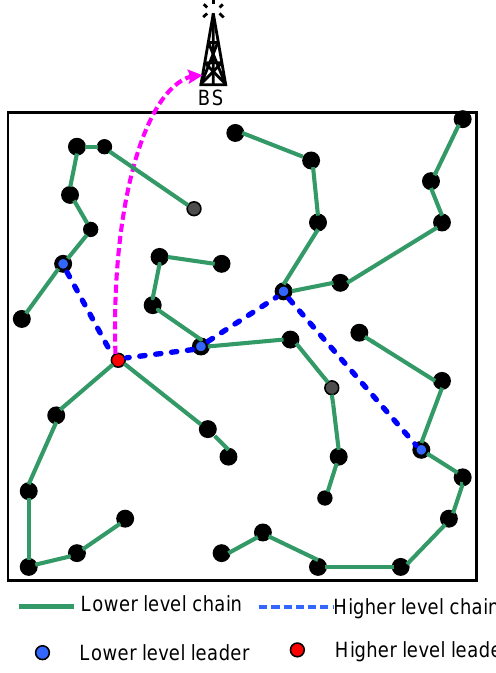
Figure 4. A sample model of the proposed